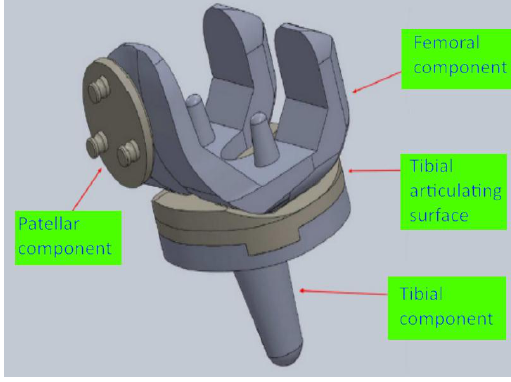
Figure 2. Parts of the designed knee replacement assembly.